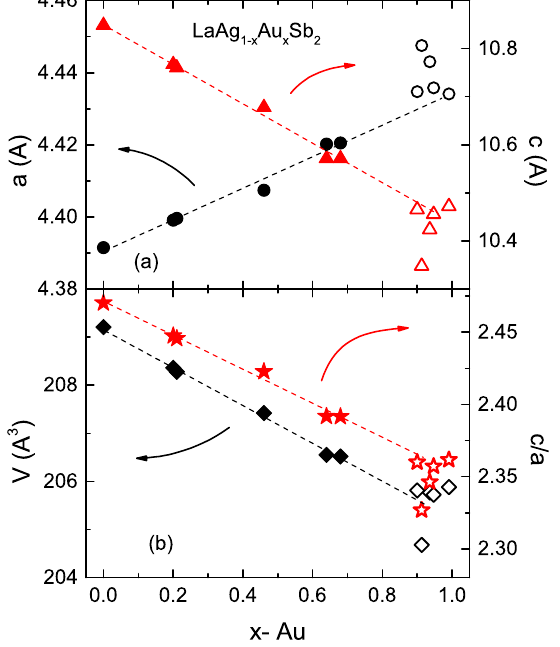
Figure 3. ( a ) Lattice parameters, ( b ) unit cell volume and c / a ratio vs. Au concentration in LaAg 1 − x Au x Sb 2 determined from Rietveld refinement (filled symbols). Data for LaAu x Sb 2 [17] (open symbols) are added for the reference. Dashed lines are guide to the eye.